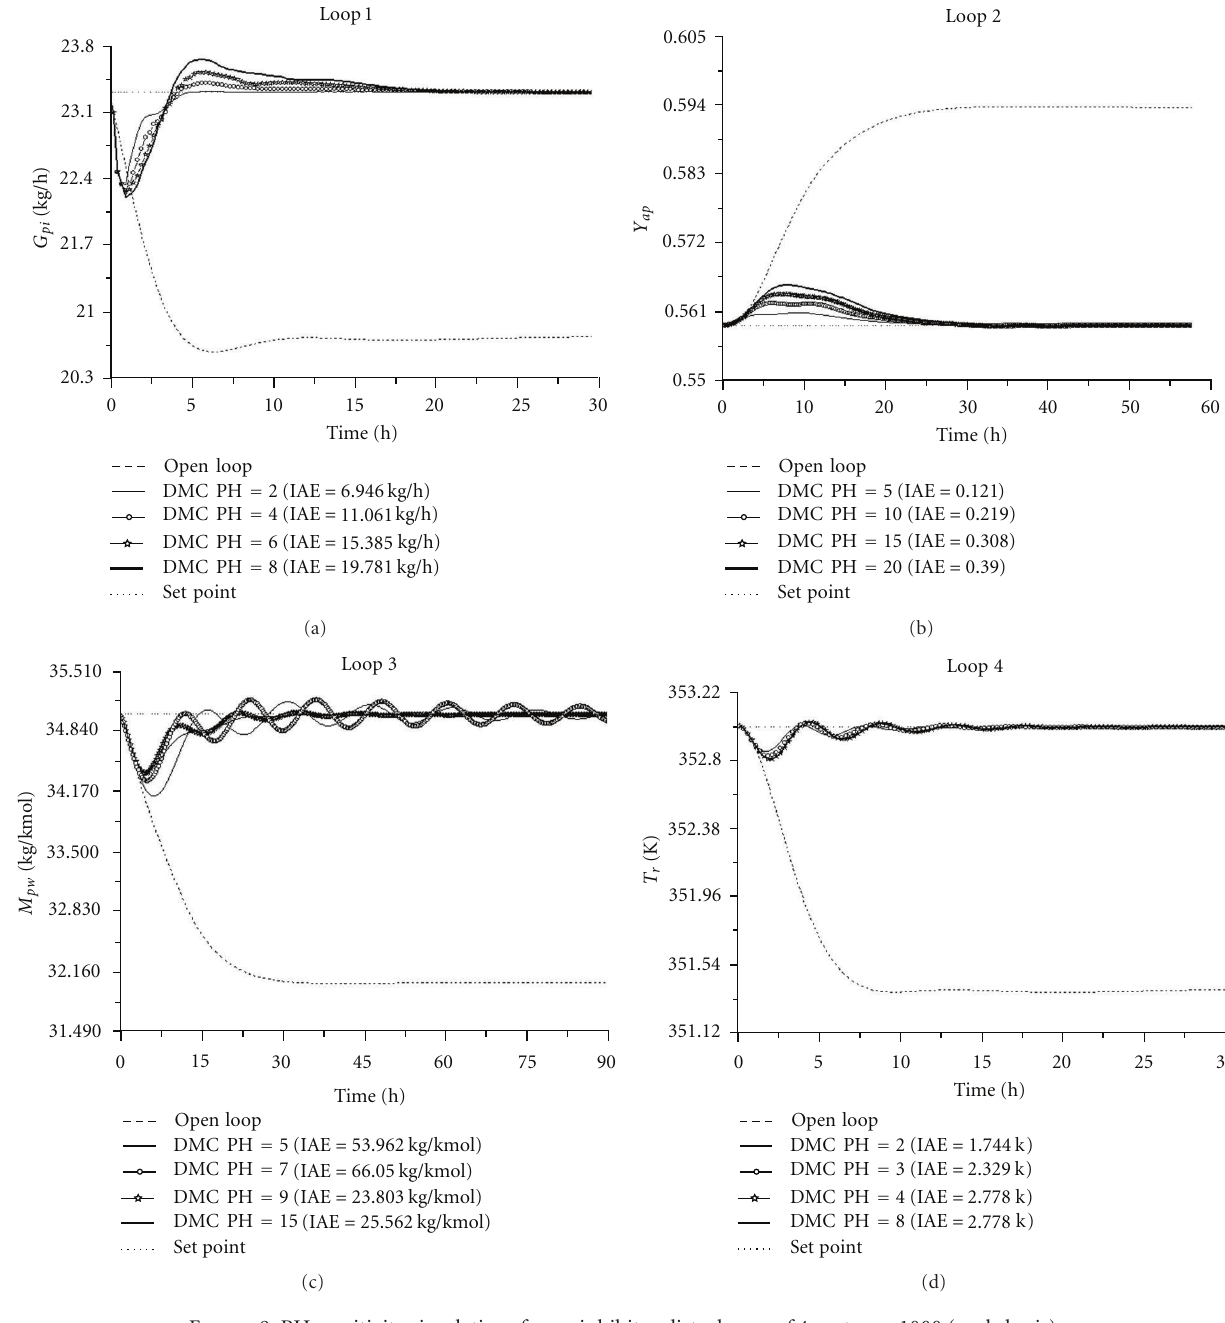
Figure 9: PH sensitivity simulations for an inhibitor disturbance of 4 parts per 1000 (mole